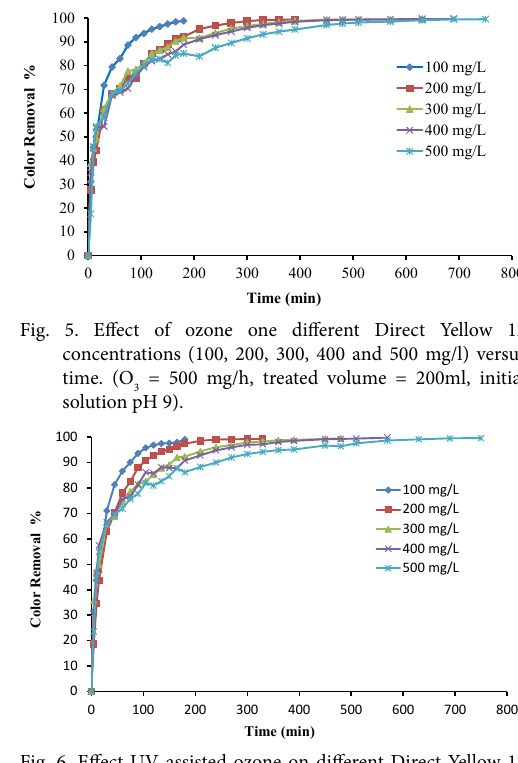
Fig. 4. pH monitoring during ozonation and advanced oxidation = 500 mg/h, treated volume = 200 ml, initial processes (O 3 solution pH 9 and 100 mg/l dye concentration).